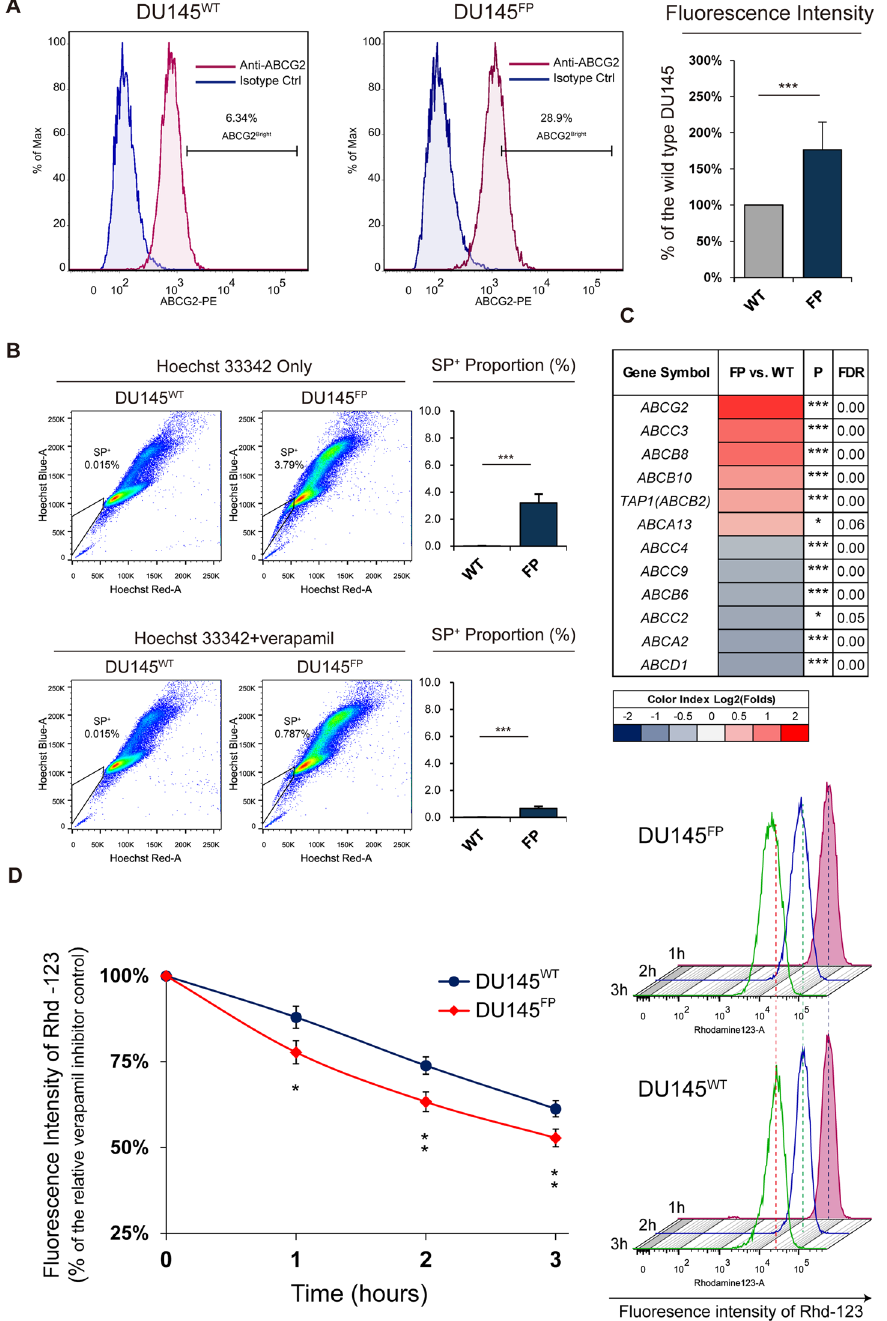
Figure 6. DU145 FP cells express higher levels of several ABC family members. ( A ) Cells were stained with phycoerythrin (PE) conjugated monoclonal antibody against ABCG2 by flow cytometry. The geometric mean values of the full fluorescence area were applied for further calculations. Summarized results are shown in the histograms on the right. The data is presented as means from three independent experiments (mean ± S.D). ( B ) Side population cells (SP + ) were detected by using Hoechst 33342 staining and flow cytometry. The SP + cells are displayed as the tail-like subpopulations in the frame on the left. Sufficient ABCG2 inhibitor verapamil is given for control staining. The data is presented as means from three independent experiments (mean ± S.D). ( C ) Transcriptome analysis of ABC-family members. The six most up- and down-regulated members are listed in the heat map. The Log 2 transformed ratio of FPKM values (e.g., FP/WT) are indicated by color-coded index bars. ( D ) The Rhd-123 efflux capacities. Shown on the right, the dashed lines are normalized to the approximate center of the fluorescence area of wild type cells to contrast the reduced fluorescence intensity in FP resistant cells. On the left, the line chart reflexes the extent of the reduced Rhd-123 concentration in both cell lines from the Rhd-123 exclusion assay. The data is presented as means from four independent experiments (mean ± S.D). Statistical significance: * p < 0.05, ** p < 0.01, *** p <